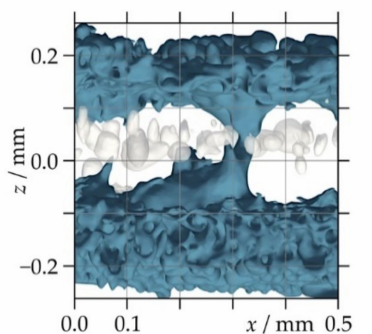
Figure 9. Semi-transparent view of visualized X-ray micro-computed tomography data through a 4 mm (= 1000 voxels) cross-section of a quenched laser-sintered (LS) polyamide 12 sheet generated with two layers showing a continuous pore through the LS sheet. The surface contours of the LS sheet are blue. The closed pores are shown in light